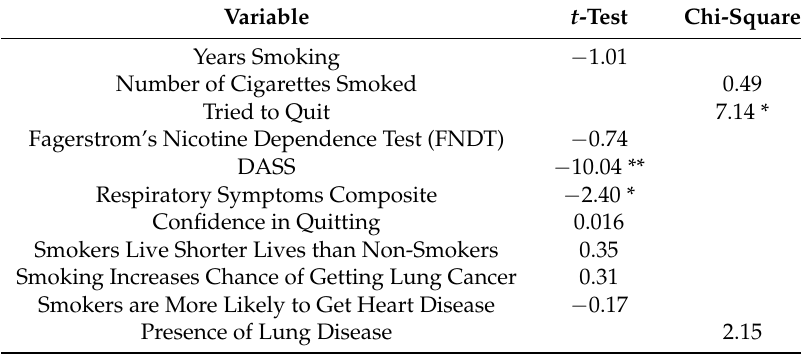
Table 2. Comparison between Clinical and Community Sample on Respiratory and Smoking- Related